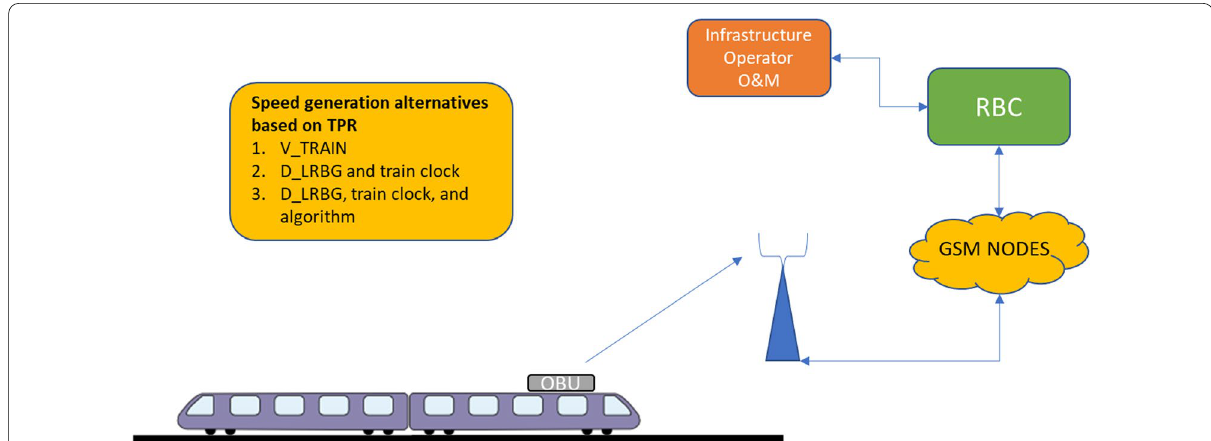
Fig. 5 Three different alternatives based on data in uplink TPRs were tested to generate speed samples: V_TRAIN variable, average speed based on D_LRBG variable, and average speed processed by an algorithm